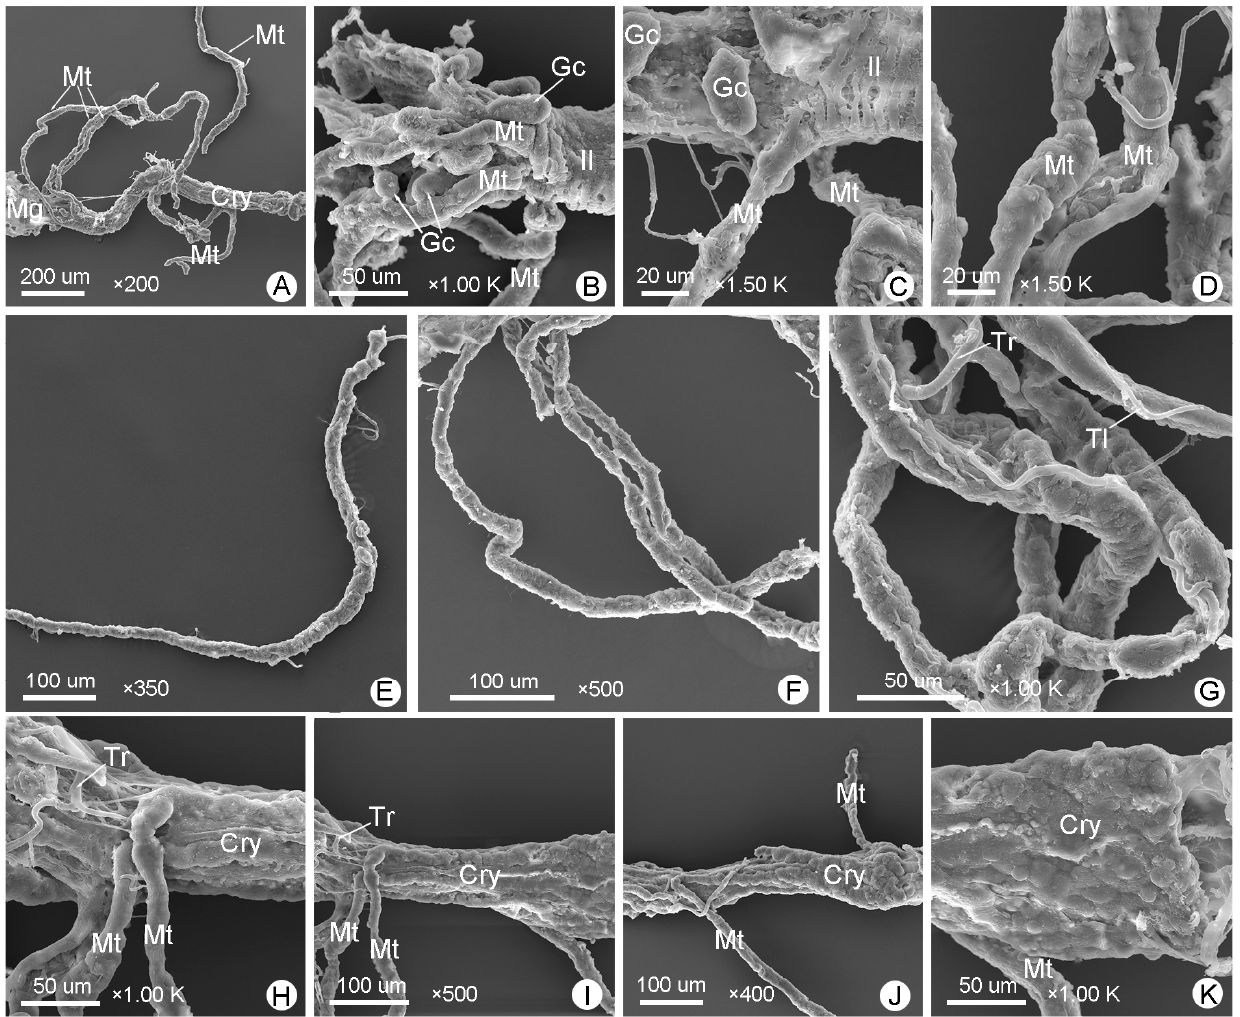
Figure 9. The Malpighian tubules of male M . ( O .) chinensis : ( A ) general view of Malpighian tubules (Mt); ( B , C ) anterior of free Malpighian tubules; ( D ) posterior of free Malpighian tubules; ( E ) a whole free Malpighian tubule; ( F ) anterior and posterior of free Malpighian tubules present different widths; ( G ) trachea and tracheoles surrounding Malpighian tubules; ( H – K ) cryptonephridial system (Cry, distal Malpighian tubules attached to the colon). Gc: gastric cecum, Il: ileum, Mg: midgut, Tl: tracheole, Tr: trachea.